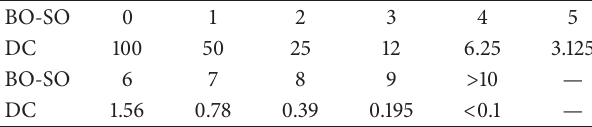
Table 1: Variation in duty cycle with BO and SO values